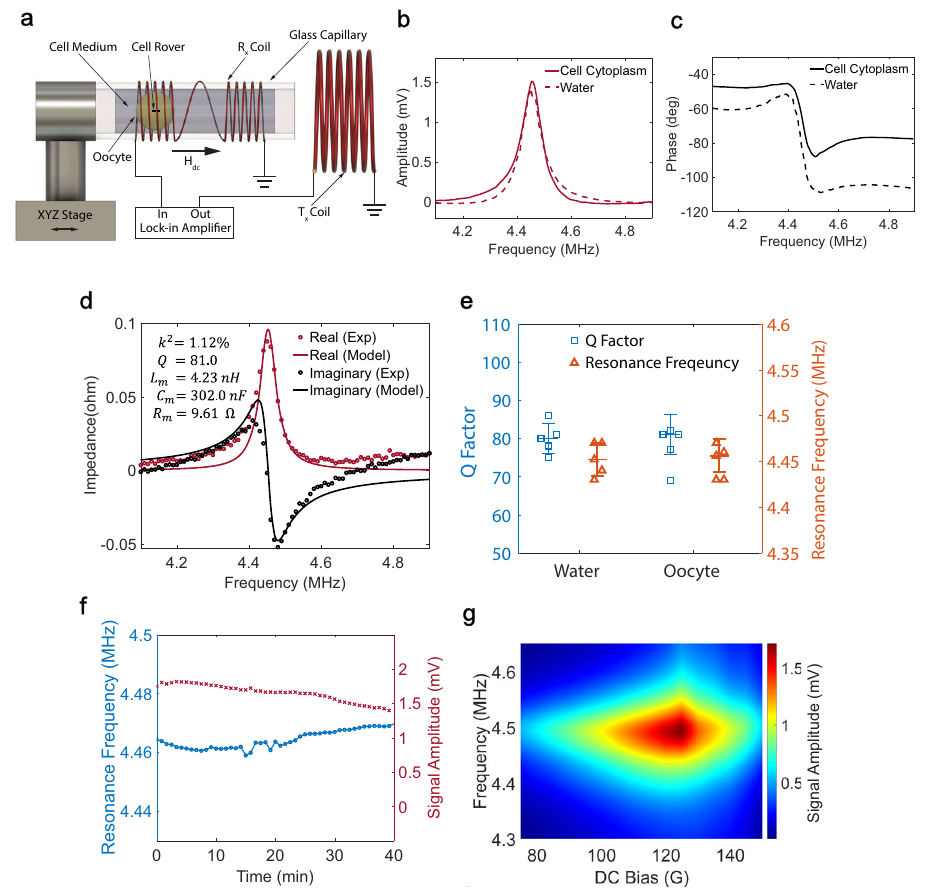
Fig. 4 | Wireless detection of Cell Rovers in Xenopus oocytes. a Schematic dia- gram showing the setup for wireless detection of a Cell Rover injected into a Xenopus oocyte. Measured b voltage amplitude and c phase of a Cell Rover wire- lessly detected from inside the cell as a function of frequency of excitation mag- netic fi eld. The resonance frequency is found to be 4.456MHz in cell cytoplasm. The dotted lines show the recorded response whenthe same resonator is in water. d Impedance vs Frequency of the Cell Rover inside the cell measured using a VNA andthecorrespondingequivalentcircuitmodel fi twhichgivesamechanicalquality factor (Q) of 81.0 and magnetomechanical coupling coef fi cient ( k 2 ) of 1.12%. The